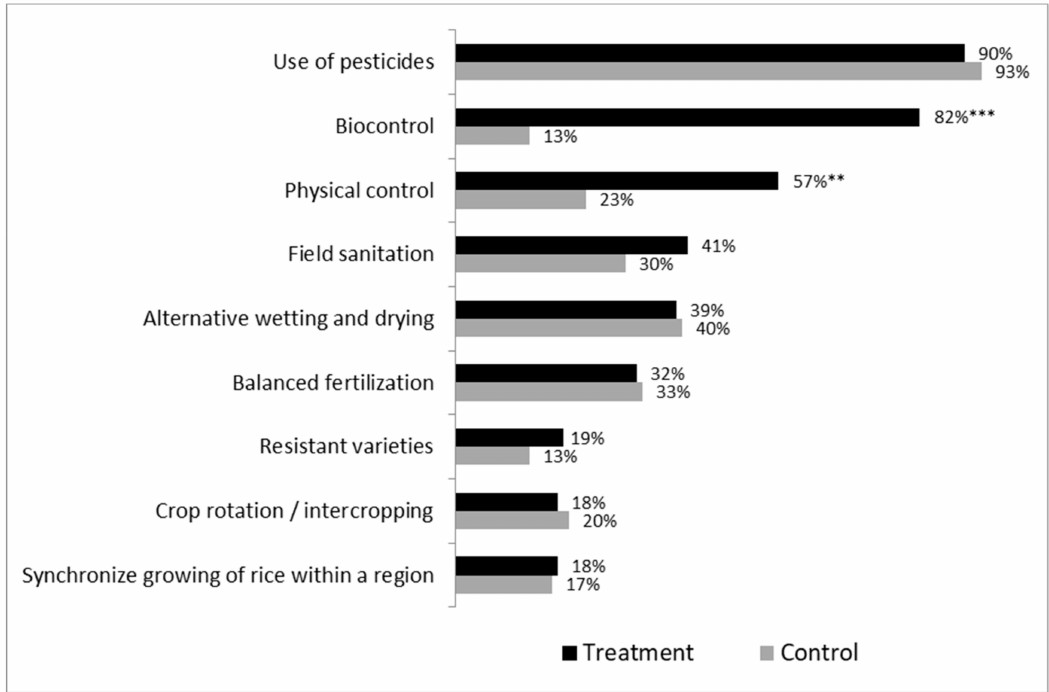
Figure 2. Adoption of rice IPM practices as reported by farmers during the HHS in the last cropping season of 2017 (treatment n = 105; control n = 30). Note: *** and ** indicate that there are significant di ff erences between treatment and control farmers, based on t -tests, at the 0.1% and 1% significance level,